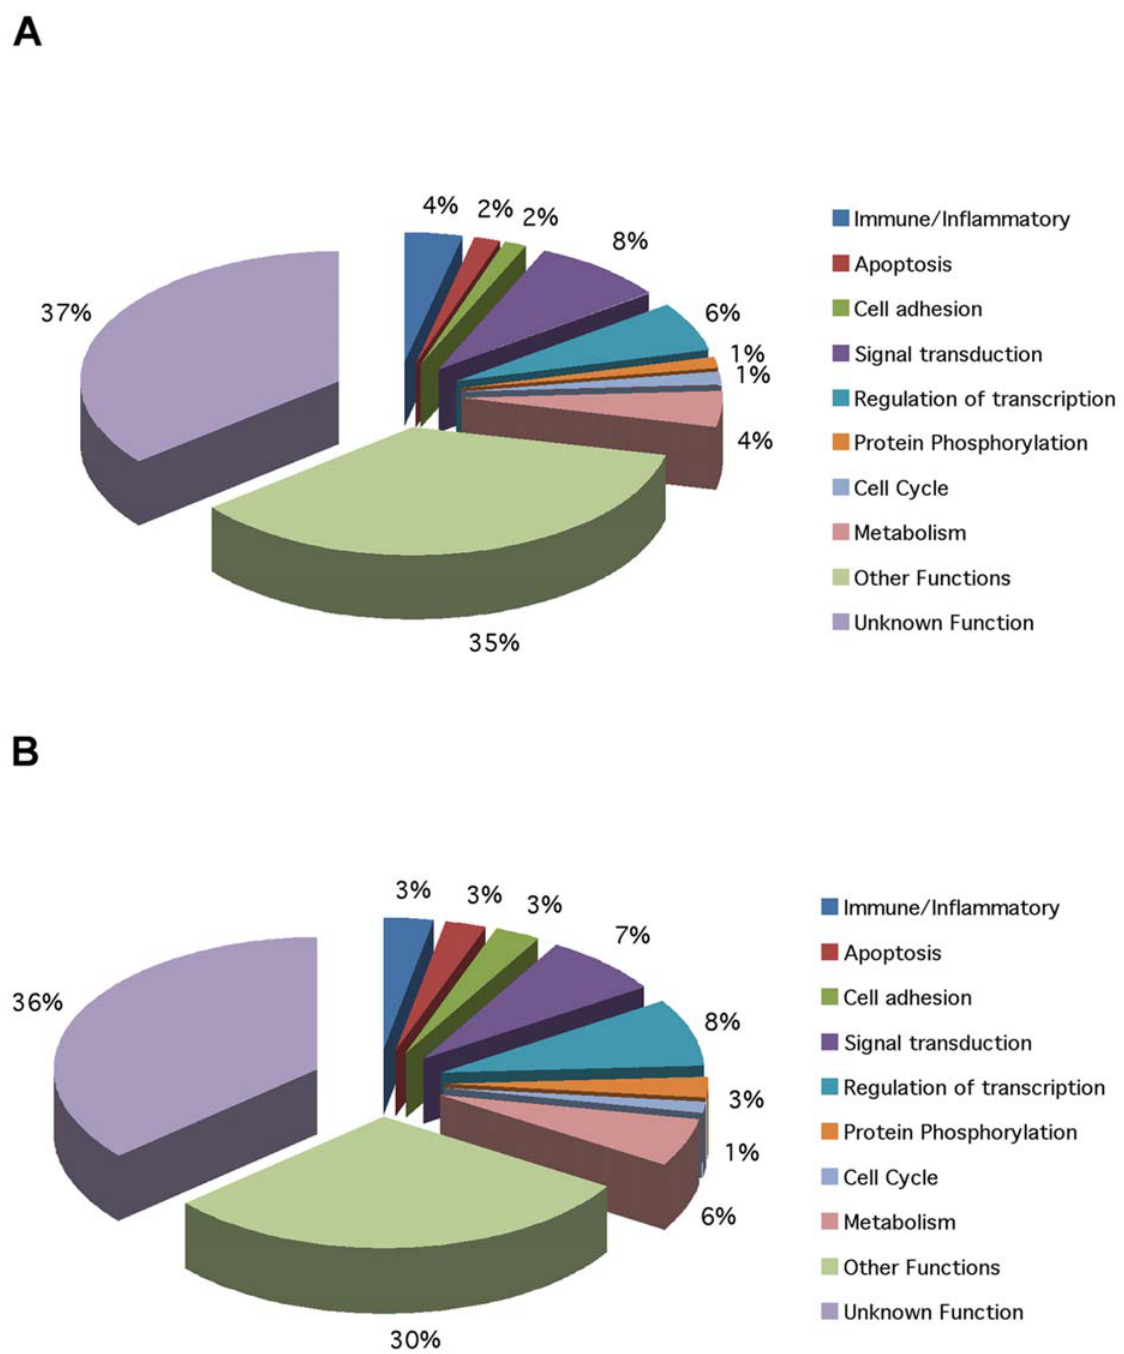
Figure 3. Pie charts showing the Gene Ontology annotations for both Test Sets for Banff 0 vs. Banff 2,3 (moderate to severe CAN). Each slice of the pie chart represents the percentage of genes represented by that functional class. A) Test Set 1 (PBL) for Banff 0 vs. Banff 2,3; B) Test Set 2 (Whole Blood) for Banff 0 vs. Banff 2,3. The first key point is that there is no difference in the general groups of differentially expressed, functional genes assigned in an unbiased fashion by analysis using Gene Ontology whether we are interrogating the profiles of PBL or whole blood (as was true for the Banff 0 vs. Banff 1 comparisons shown in Figure 1). The second key point is that the number of differentially expressed immune/ inflammatory genes is significantly less than observed in mild CAN with many more genes linked to metabolic and other pathways consistent with the hypothesis that early stages of CAN are driven by immune/inflammatory mechanisms and tissue injury but later stages reflect slowly progressive renal dysfunction and fibrosis. doi:10.1371/journal.pone.0006212.g003 Test Set 1 and 40 matches for the 1429 genes for mild CAN in moderate/severe CAN in Test Set 1 and 9 matches in the 545 Test Set 2. There were no matches for the 62 consensus genes for genes for moderate/severe CAN in Test Set 2. All protein/ moderate/severe CAN but 9 matches in the 172 genes for transcript matches are listed in Supplementary Data Table S9.